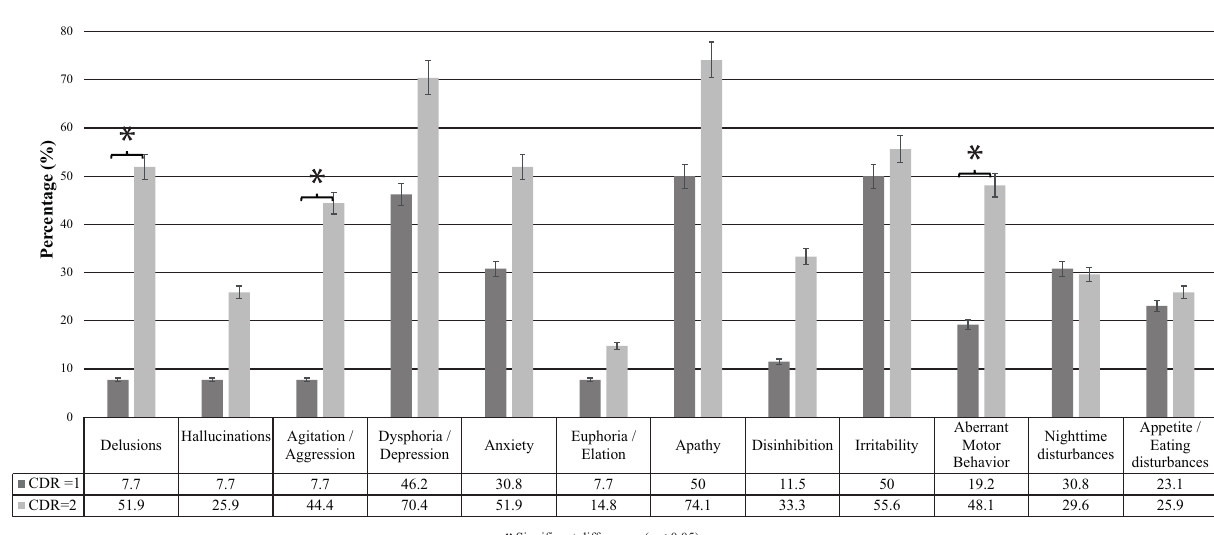
Figure 2. Prevalence of neuropsychiatric symptoms according to the NPI-Q in patients with mild (CDR=1) and moderate (CDR=2) AD.